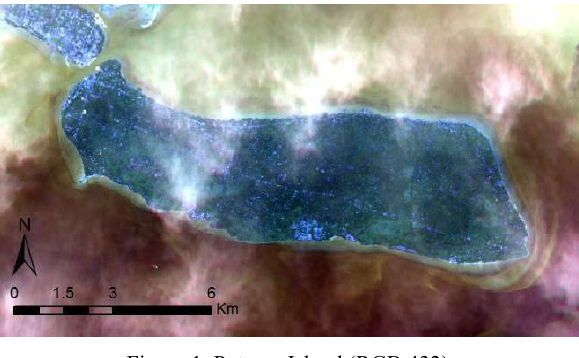
Figure 1. Poteran Island (RGB 432) Figure 1 shows the island using Landsat 8 RGB Natural Color.